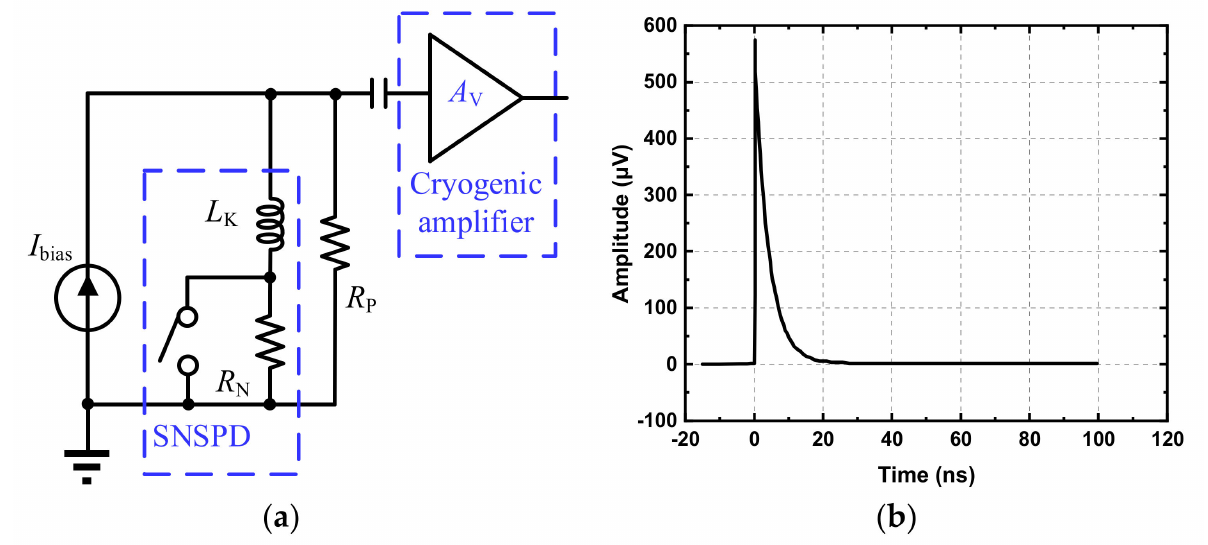
Figure 3. The connection of the SNSPD and readout amplifier, and output signal: ( a ) The SNSPD model and its connection with the amplifier; ( b ) Typical SNSPD output pulse